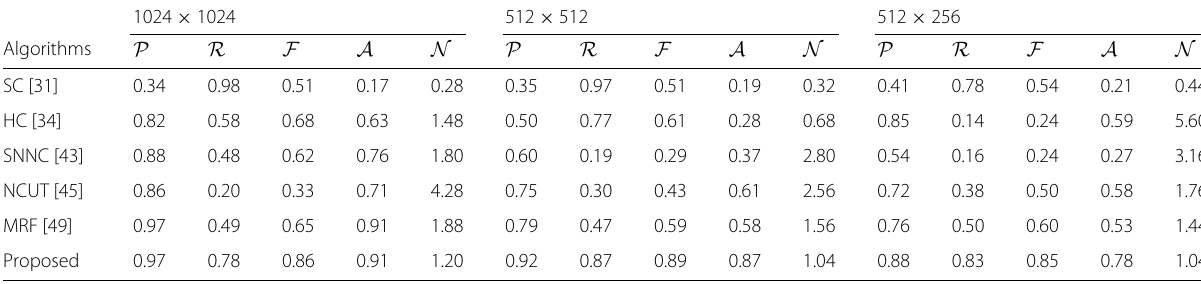
Table 2 Comparison of clustering algorithms on D 2 Algorithms